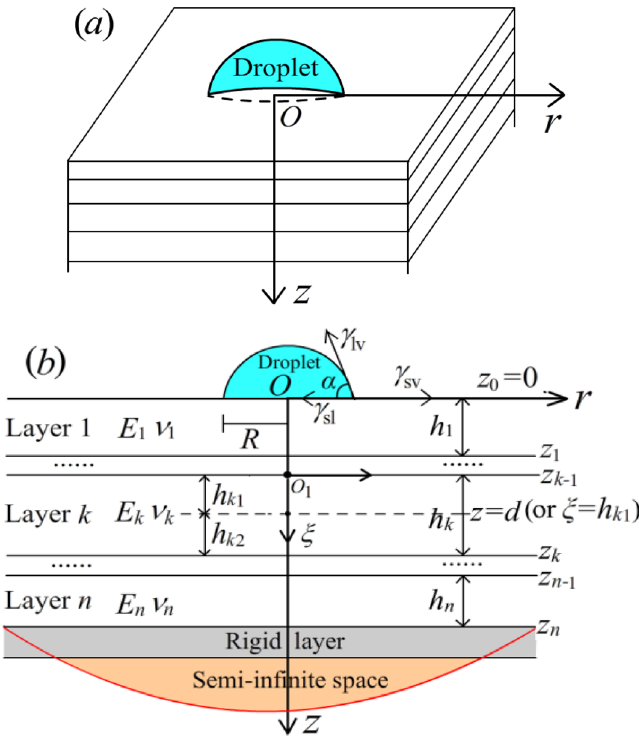
Figure 1. The sketch of droplet wetting with layered